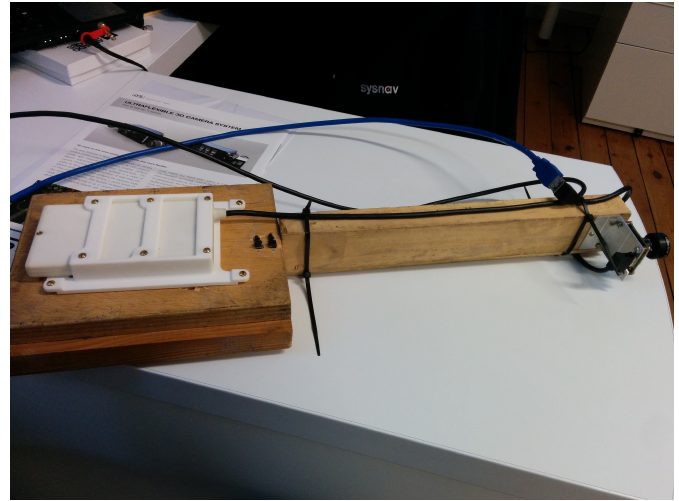
Figure 4. The sensor setup used in this work. The white box on the left side contains the MIMU sensor, the camera is on the right side. Both sensors are rigidly attached through a non-magnetic, non conductive material